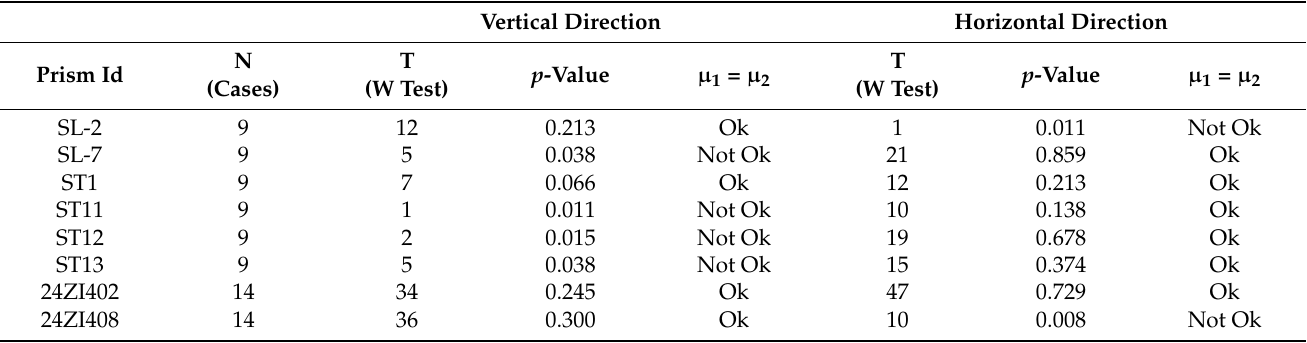
Table 6. Wilcoxon statistic test of the vertical and horizontal TSX-Proj. Vertical Direction Horizontal Direction